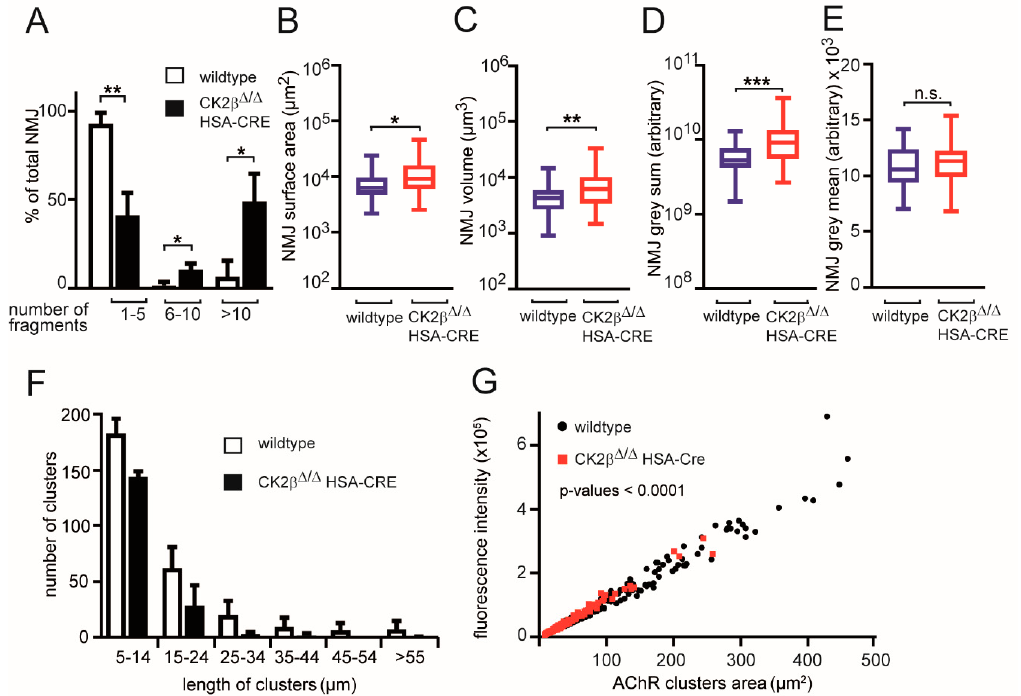
Figure 4. Neuromuscular junctions (NMJ) morphometric analysis of wild-type and CK2 β -deficient skeletal muscles and myoblasts. ( A ) Morphometric analysis of whole-mount bungarotoxin (BTX) staining of muscles of wildtype and CK2 β -deficient mice. Mutant muscles lacking CK2 β displayed a significantly higher NMJ fragmentation when compared to wild-type muscles; (** p < 0.01; * p < 0.05; unpaired two-tailed Student’s t-test; n > 50 NMJs per genotype from at least three mice per genotype). Error bars indicate s.e.m. ( B – E ) Morphometric analysis of surface area ( B ), volume ( C ), total fluorescence intensity ( D ), and mean fluorescence intensity ( E ) of NMJs in whole-mount preparations of soleus of wild-type and conditional CK2 β -deficient mice following staining with BTX. All the analyzed NMJ features were significantly altered in CK2 β -deficient muscles except for mean fluorescence intensity ( E ) when compared to wild-type muscles (*** p < 0.001, ** p < 0.01; *, p < 0.05; n.s. means not significant; unpaired two-tailed Student’s t-test; soleus wild-type; n > 50 NMJs, CK2 β -deficient soleus n > 50 NMJs). NMJs were sampled from three mice per genotype. Error bars indicate s.e.m. ( F , G ) Morphometric analysis of length ( F ) and fluorescence intensity per area ( G ) was performed with clustered and BTX stained acetylcholine receptors (AChRs) on cultured primary myotubes. Clusters were sampled from three primary muscle cell extracts per genotype. Error bars indicate s.e.m.